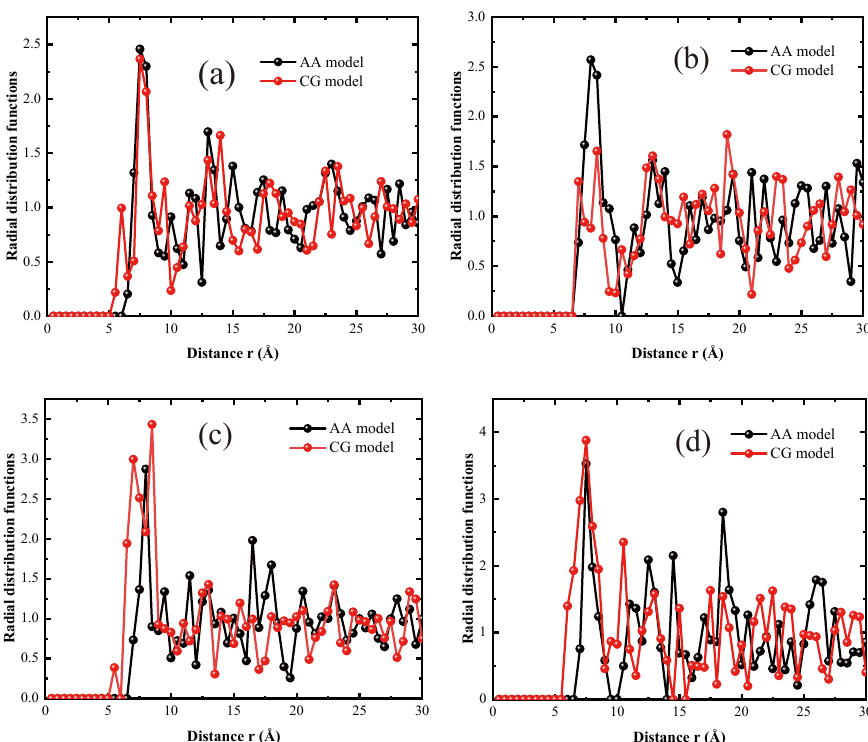
Figure 4. Radial distribution function (RDF) curves for ( a ) particle type ‘A’, ( b ) particle type ‘B’, ( c ) particle type ‘C’, and ( d ) particle type